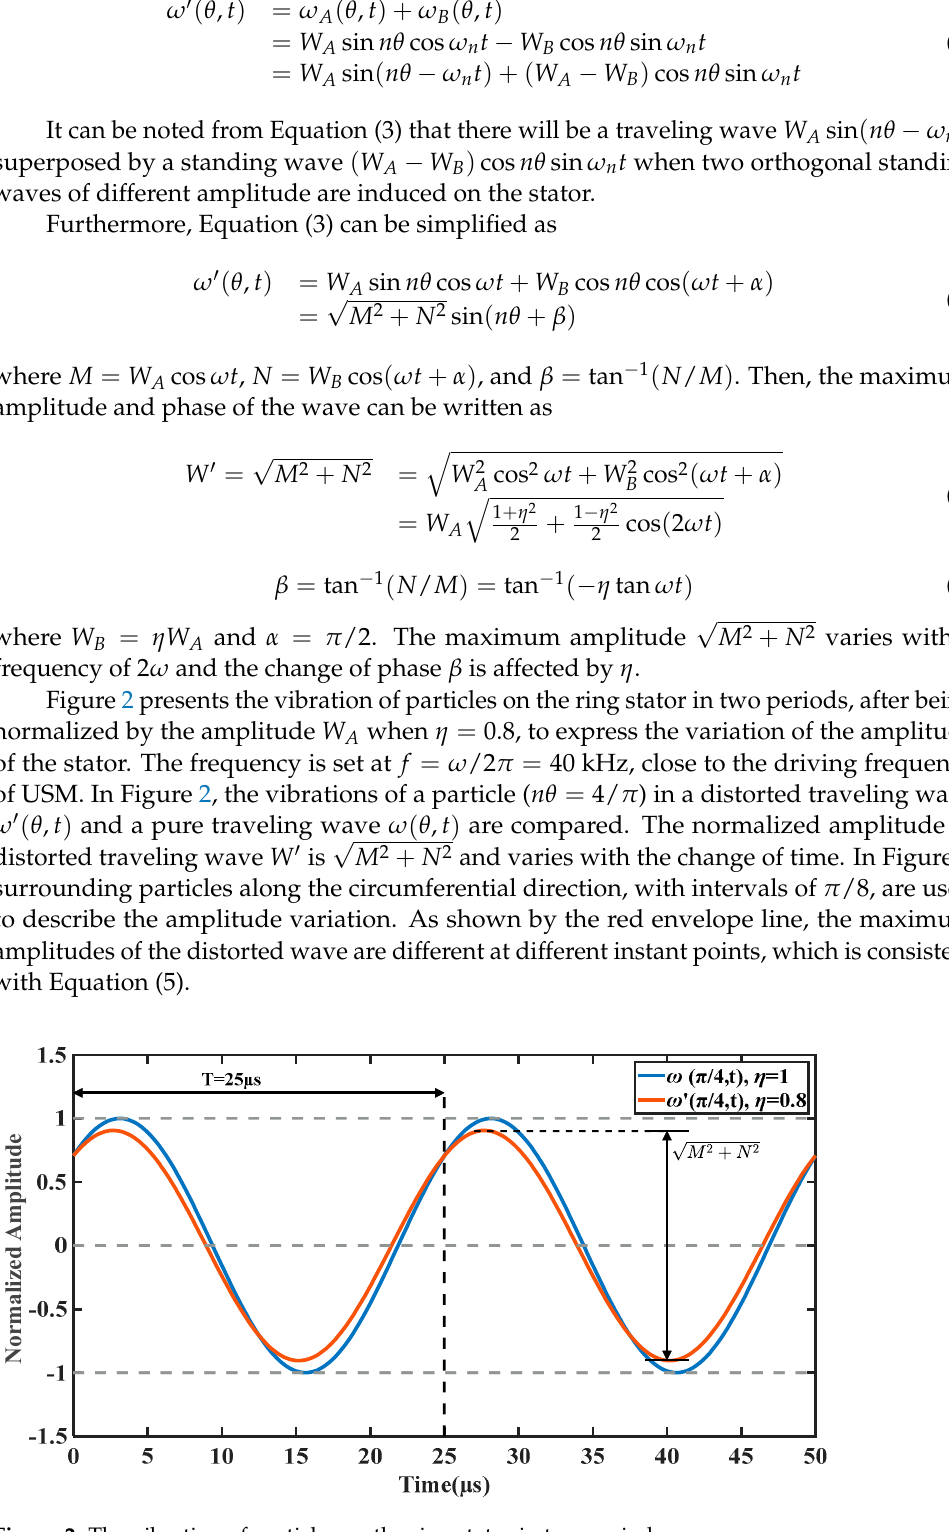
Figure 2. The vibration of particles on the ring stator in two periods.